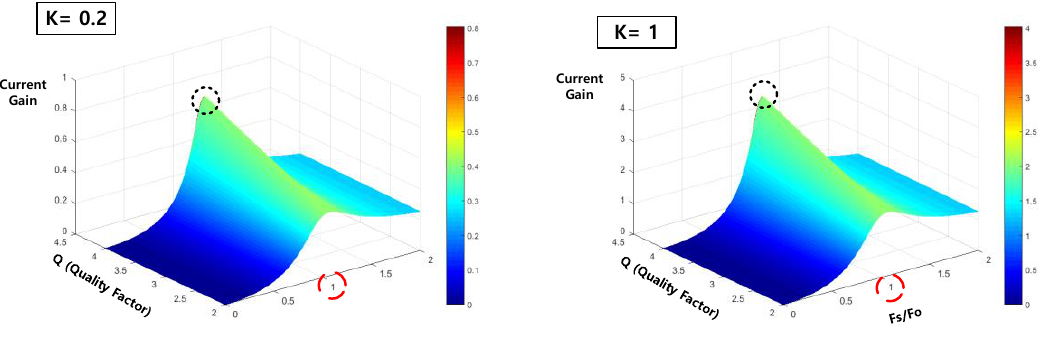
Figure 2. Voltage gain G v according to load quality factor and ω n ( k = 1, k = 0.2).